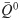
Learning variances in a feed-forward network.A: Schematic representation of the input-output mapping for covariances defined by the afferent weight matrix B, linking m = 10 input nodes to n = 2 output nodes. B: Objective output covariance matrices Q¯0 for two categories of inputs. C: Matrix for the 5 input covariance patterns P0 (left column) for the first category, with their images under the original connectivity (middle column) and the final images after learning (right column). The training leads to a larger variance (darker pixel) for output 1 (bottom left pixel of matrices in the right column) than for output 2 (top right pixel). D: Same as C for the second category. The training leads to a larger variance for output 2 than for output 1 except for the last pattern. E: Evolution of individual weights of matrix B during ongoing learning. F: The top panel displays the evolution of the error between Q0 and Q¯0 at each step. The total error taken as the matrix distance E0 in Eq (25) is displayed as a thick black curve, while individual matrix entries are represented by gray traces. In the bottom panel the Pearson correlation coefficient between the vectorized Q0 and Q¯0 describes how they are “aligned”, 1 corresponding to a perfect linear match.